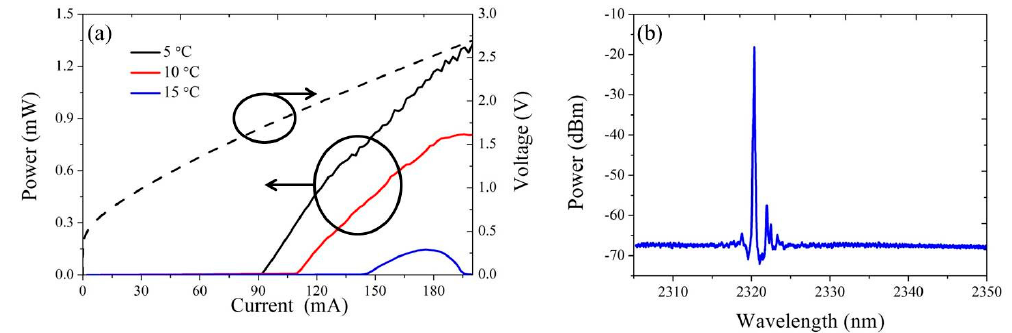
Figure 5. ( a ) Continuous-wave (CW) light-current-voltage (L-I-V) curve of a III–V-on-silicon DFB laser with grating period of 348 nm; ( b ) emission spectrum of the DFB laser driven with 190 mA bias current at 10 °C.